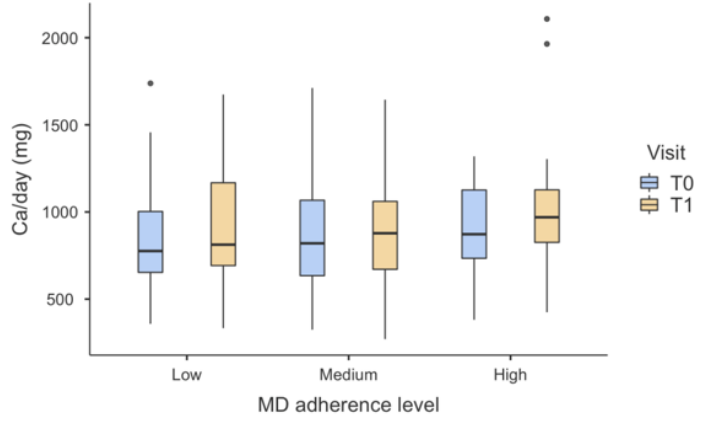
Figure 4. Box-plots chart showing dietary calcium intake in the three degrees of MD adherence, at T0 and T1. No statistically significant differences were observed. Outliers are represented by dots.